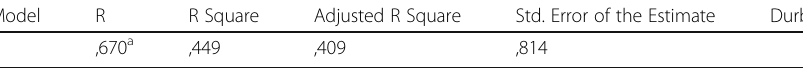
Table 17 Model Summary R2 b Model